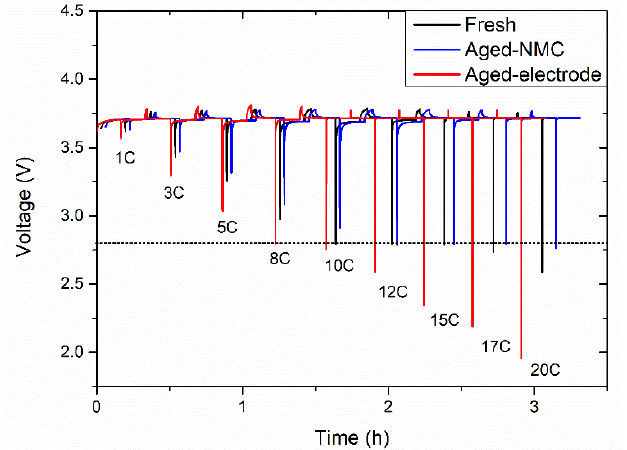
Figure 5. Power tests conducted on the lithium-ion cells with the NMC811 electrodes subjected to different aging protocols.